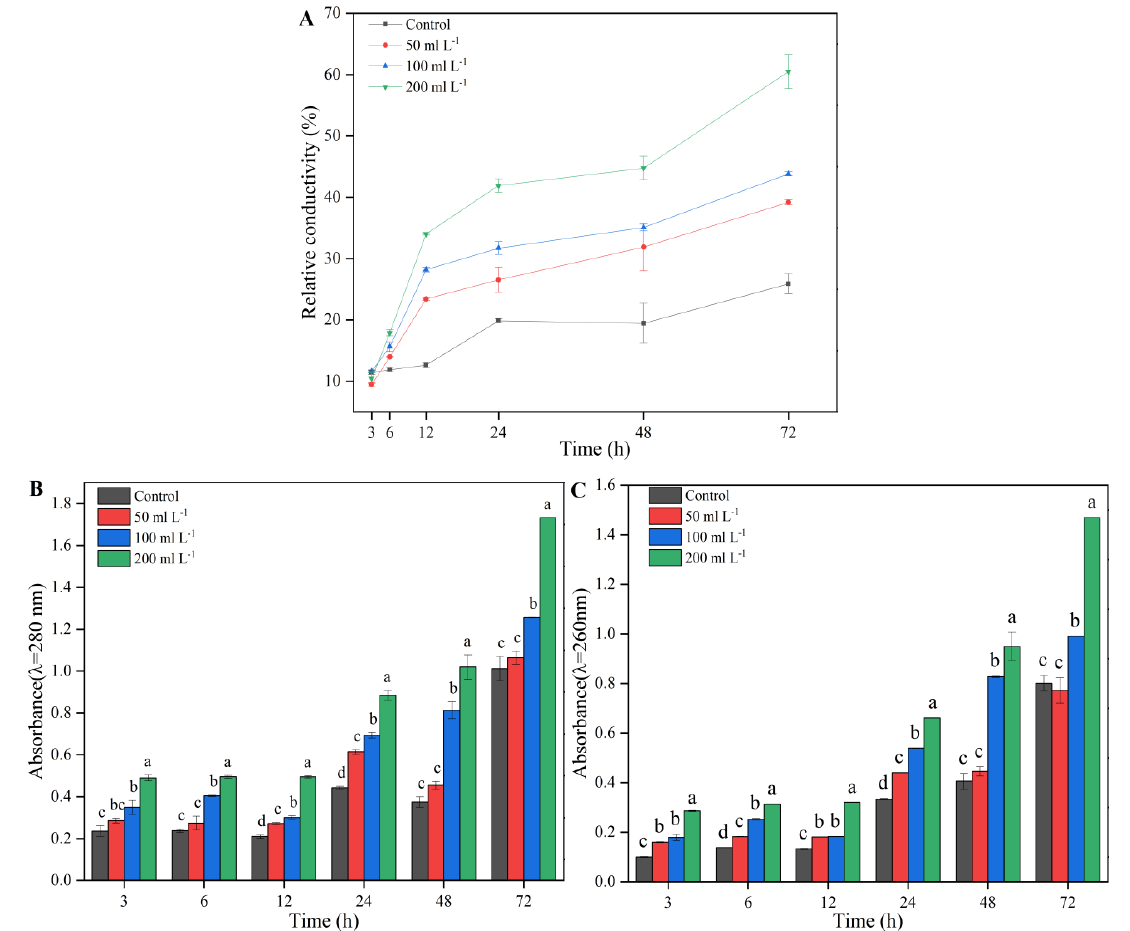
Figure 10. Detection of relative conductivity ( A ), nucleic acids leakage ( B ), and proteins leakage ( C ) in A. alternata cultures after treatment with 50 mL L − 1 , 100 mL L − 1 , and 200 mL L − 1 aseptic filtrate for 3 h, 6 h, 12 h, 24 h, 48 h, and 72 h. Data are displayed as the mean ± SE. Bars with the same lowercase letters indicate no significant difference between treatments ( p <